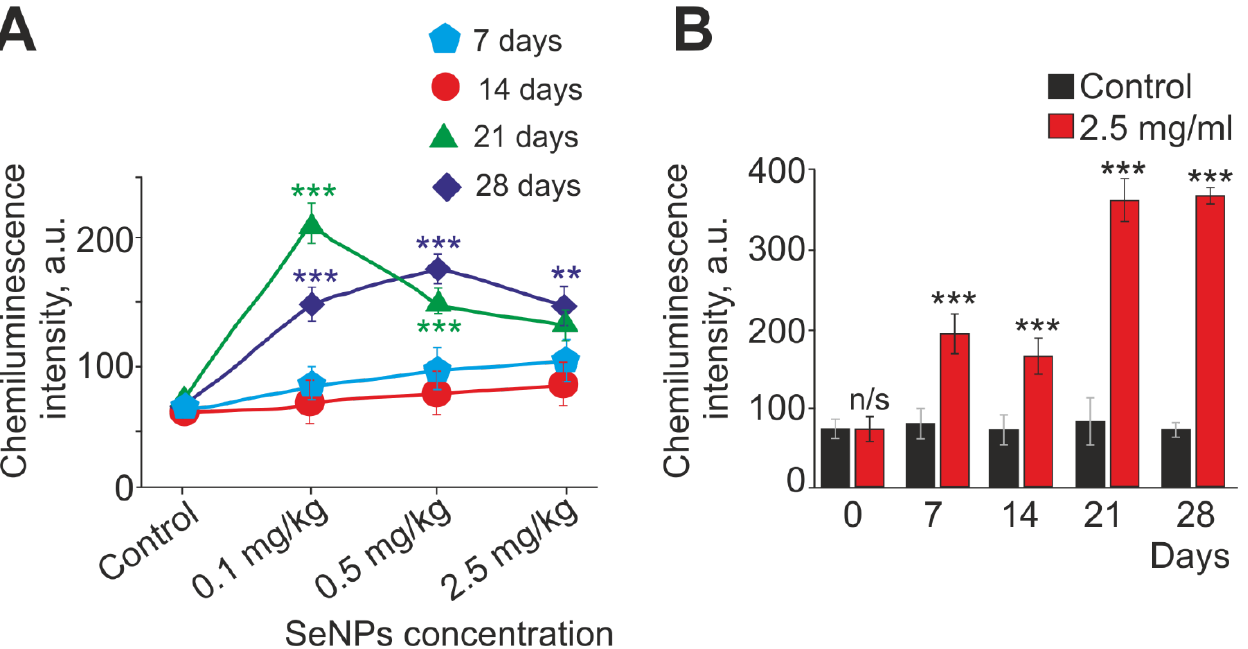
Figure 2. Effect of SeNP injections in vivo on spontaneous ROS production by neutrophils. ( A )—The changes in spontaneous ROS production in neutrophils of the control and experimental groups with injection of 0.1 mg Se/kg, 0.5 mg Se/kg, and 2.5 mg Se/kg SeNPs. Data are presented at 7 (blue curve), 14 (red), 21 (green), and 28 days (dark blue) after daily injection. Control is the control group with injection of saline. ( B )—Dynamics of changes in spontaneous ROS production in neutrophils of the control (red) and experimental group with intraperitoneal injection of 2.5 mg Se/kg (black) were estimated at 0, 7, 14, 21, and 28 days after daily injection of SeNPs or saline (control). The neutrophil ROS generation was determined by luminol-dependent chemiluminescence with auto- mated multiplate reader (Spark™ 10M multimode microplate reader). Data are shown as the mean of chemiluminescence intensity, arb.units ± SEM of five animals for each group. Statistical analysis of experimental groups versus control was performed with paired t -test. Significance between group means: *** p < 0.001 and ** p < 0.01. Values not marked with an asterisk are n/s—no